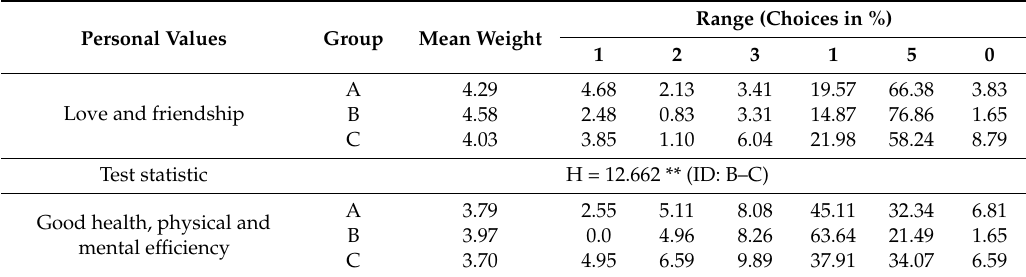
Table 4. Comparison of scores for personal values in studied